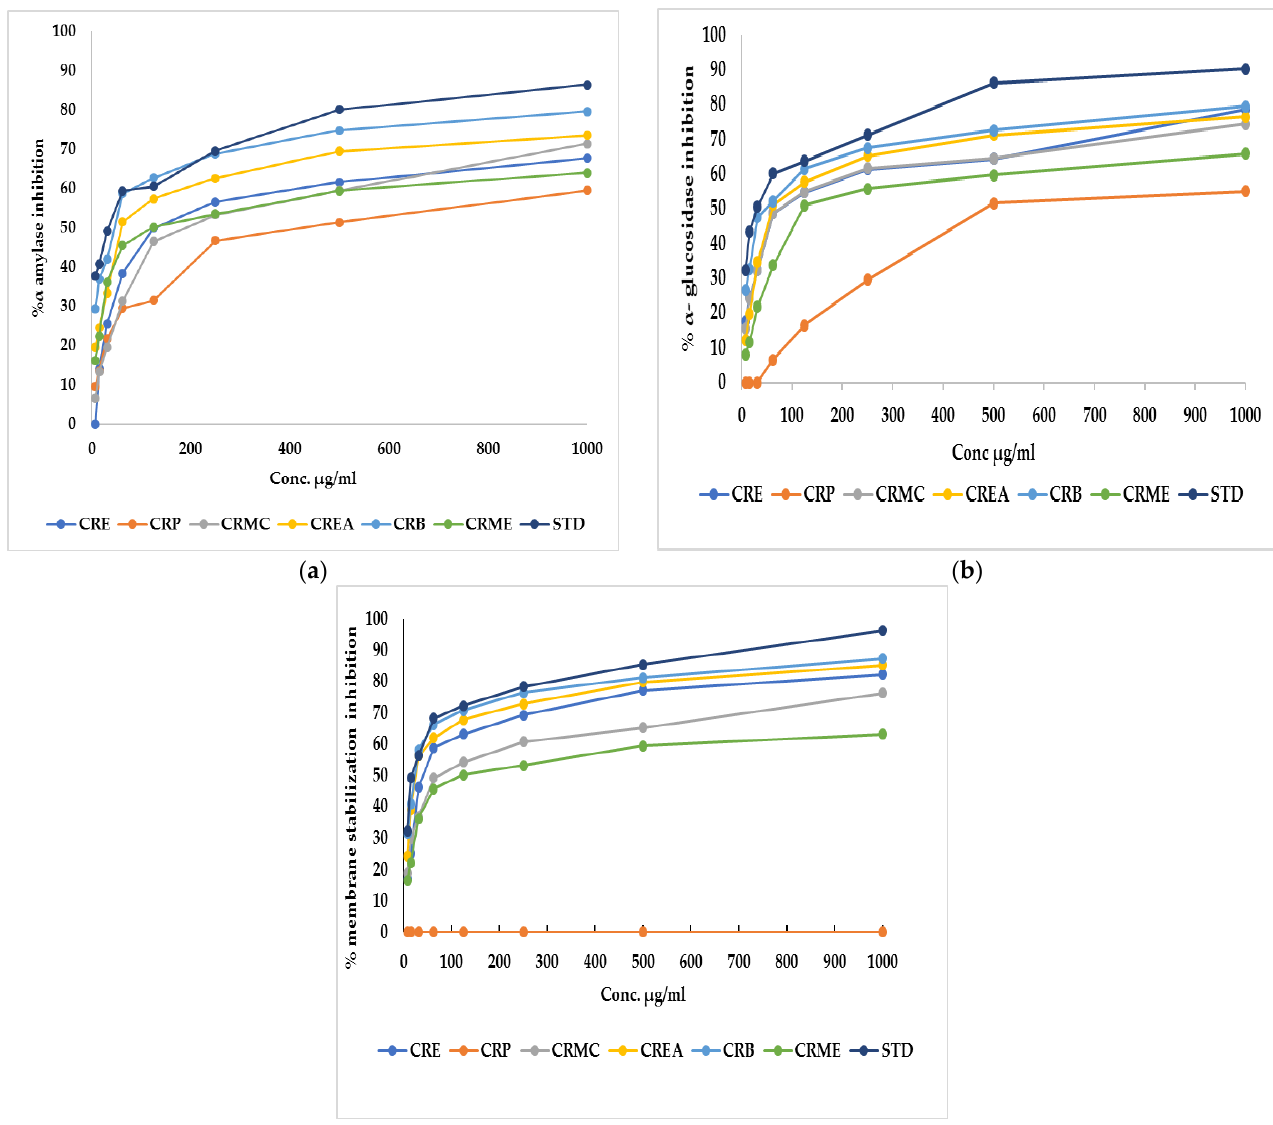
Figure 1. ( a ) α -Amylase inhibition percentage, ( b ) α -glucosidase inhibition percentage, and ( c ) mem- brane stabilization inhibition percentage of Colvillea racemosa ethanol extract (CRE) and its fractions (petroleum ether (CRP), methylene chloride (CRMC), ethyl acetate (CREA), n-butanol (CRB), and methanol (CRME)). STD (acarbose ( a,b )and indomethacin ( c )).